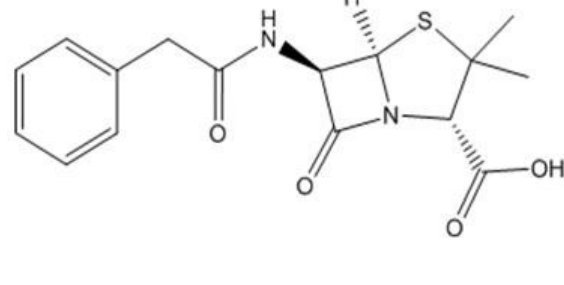
Figure 1. Penicillin G, the gold standard Penicillin